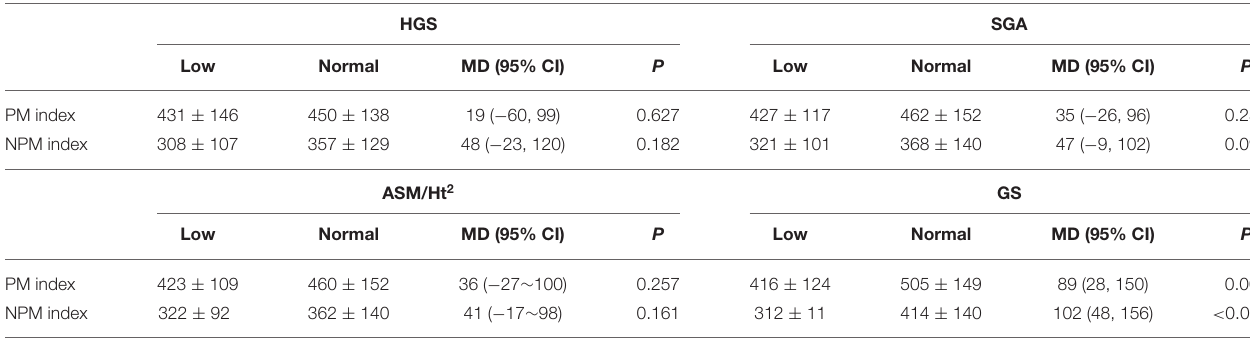
TABLE 3 | Comparison of the PM and NPM indices between the groups of HGS, SGA, ASM/Ht2, or GS. HGS SGA